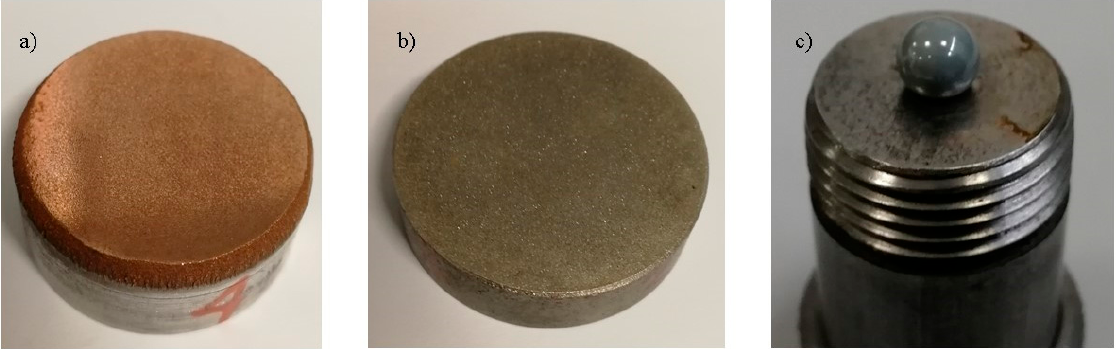
Figure 1. Samples for testing: ( a ) DMMC, ( b ) D30, and ( c ) Si 3 N 4 ball. Table 1. Sample dimensions and material physical properties of substrates and balls.